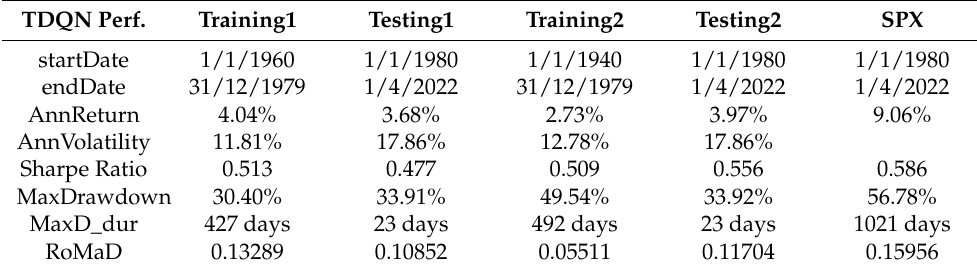
Table 1. Performance of the TDQN deep RL algorithm, on long-term investing, using the SPX index. In this simulation, we trained on 20 years of data (1960–1980) and tested on 42 years (1980–2022), with quite modest results. In a second simulation, we trained on 40 years (1940–1980) and tested on 42 years (1980–2022), with slightly better results. The RL method, in our limited testing, obtained modest performance, but reduced drawdowns significantly. With the longer training period, the Sharpe ratio improved. The SPX itself had a Sharpe ratio of 0.586 in the test period. Note that the risk-free rate was set to zero in computing the Sharpe